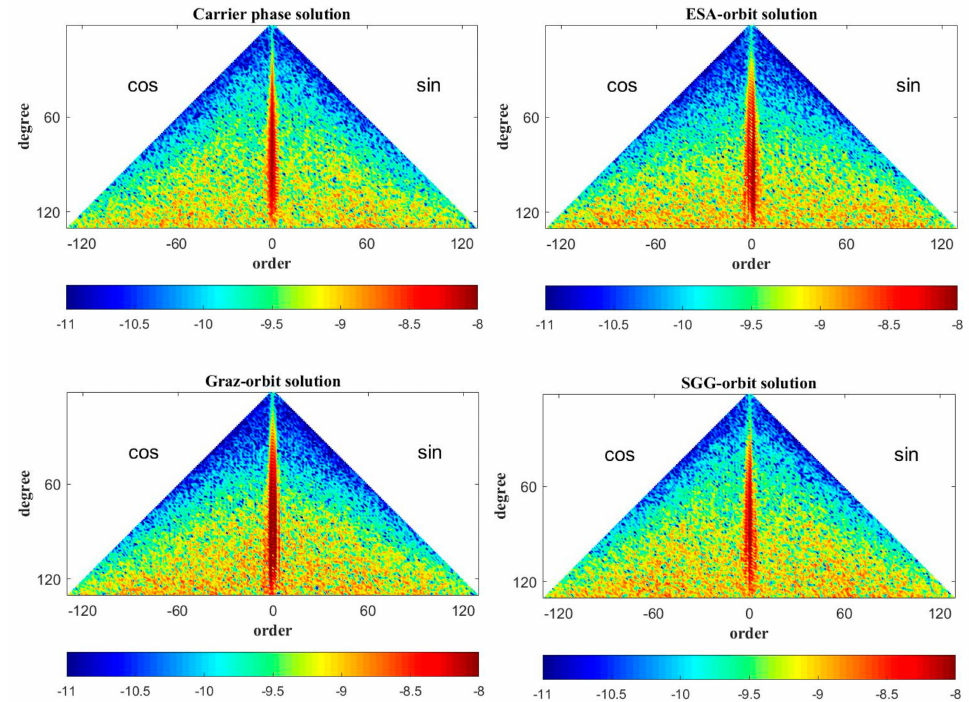
Figure 3. Spherical harmonics triangle of the estimated geopotential coe ffi cients when compared with